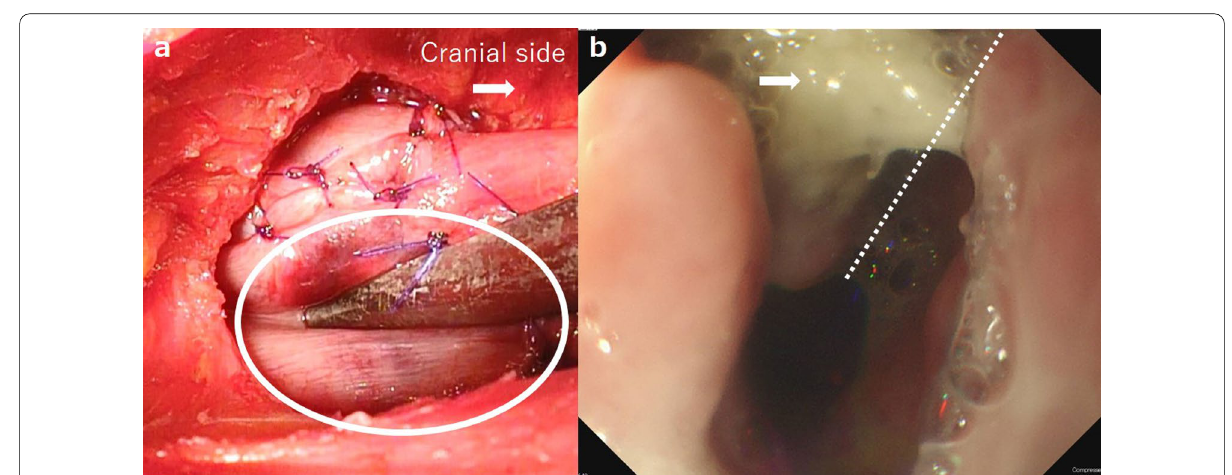
Fig. 2 a Anastomosis at the end of surgery in case 2. The tip of the gastric conduit appeared pale with the trace of the upper end of the manubrium as the clear boundary (white circle). b Endoscopic findings in case 2 on postoperative day 8. The dashed line indicates the staple line of the conduit at the lesser curvature. Leakage was confirmed at the ventral side of the tip of the conduit (white